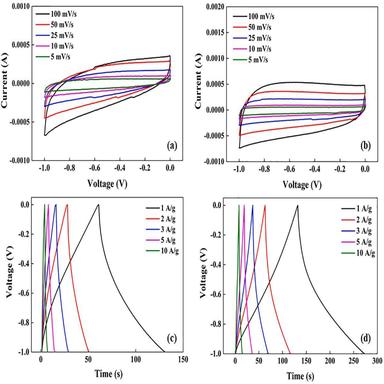
CV curve at different scanning rates (a, b) and the GCD curve at different current densities (c, d) for non-activated (GY-carbon) and KOH-activated (GY-KOH carbon) carbon materials derived from BNC.